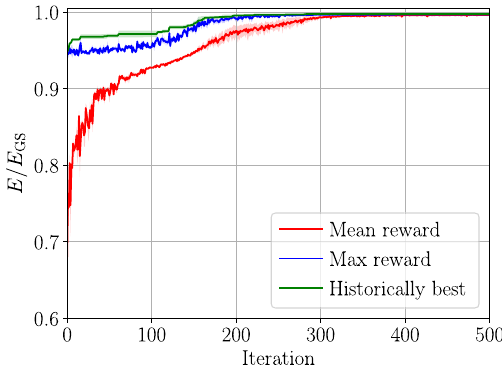
FIG. 11. Spin-1 Ising model: training curves for CD-QAOA with energy minimization as a cost function. The mean negative energy density (red) is computed for a sample generated using the policy at the current iteration; max (blue) is the maximum within the sample; the historically best (green) is the best-encountered policy during the entire training process (i.e., considering all iterations). Each curve shows the average out of three simulations corresponding to three different seed values for the high-level RL optimization; the fluctuations around the seed averages are shown as a narrow shaded area. The total duration is T ¼ 28 , and the number of spin-1 particles is N ¼ 8 . The initial and target states are j ψ i i ¼ j ↓ (cid:4) (cid:4) (cid:4) ↓ i and j ψ i ¼ j ψ GS ð H Þi for h z =J ¼ 0 . 809 (cid:2) and h x =J ¼ 0 . 9045